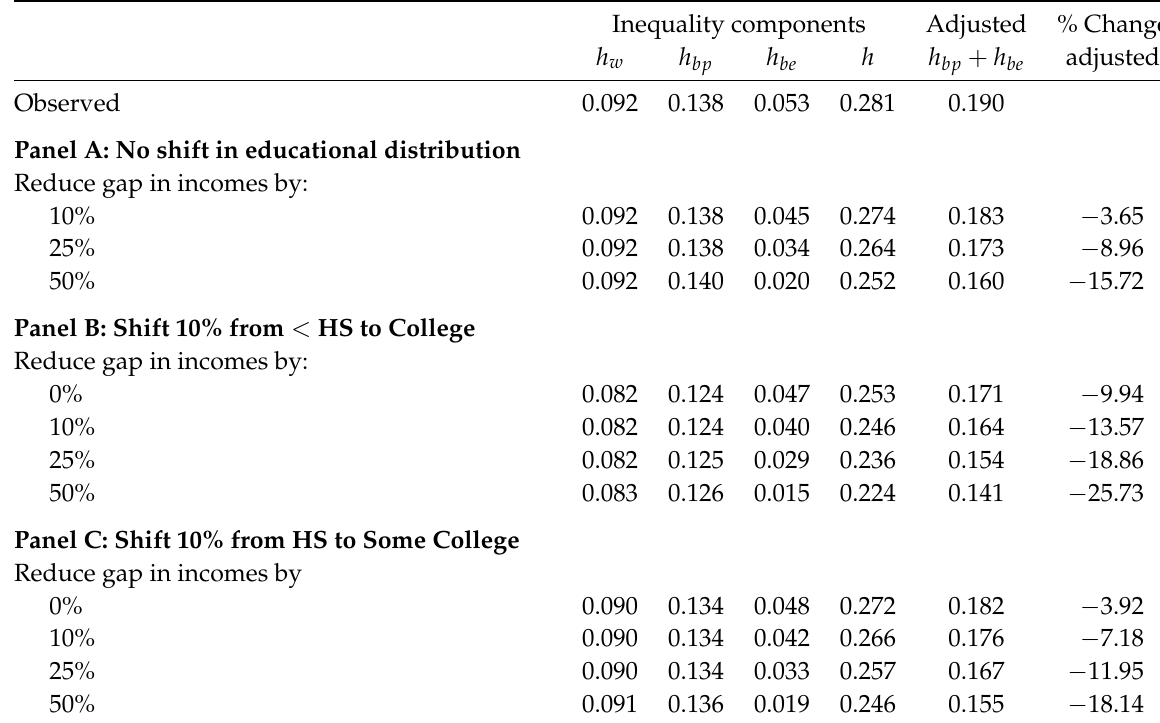
Table 6: Simulated Inequality Reducing the Income Gap by 10, 25 and 50